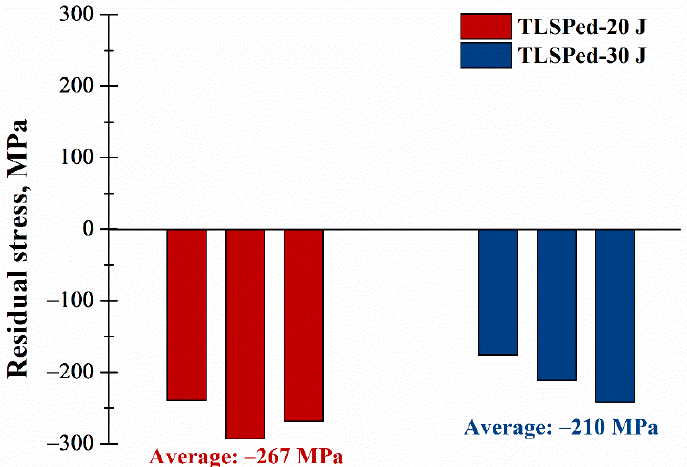
Figure 8. Compressive residual stress measured on the surface of the TLSPed-20 J and TLSPed-30 J specimens.